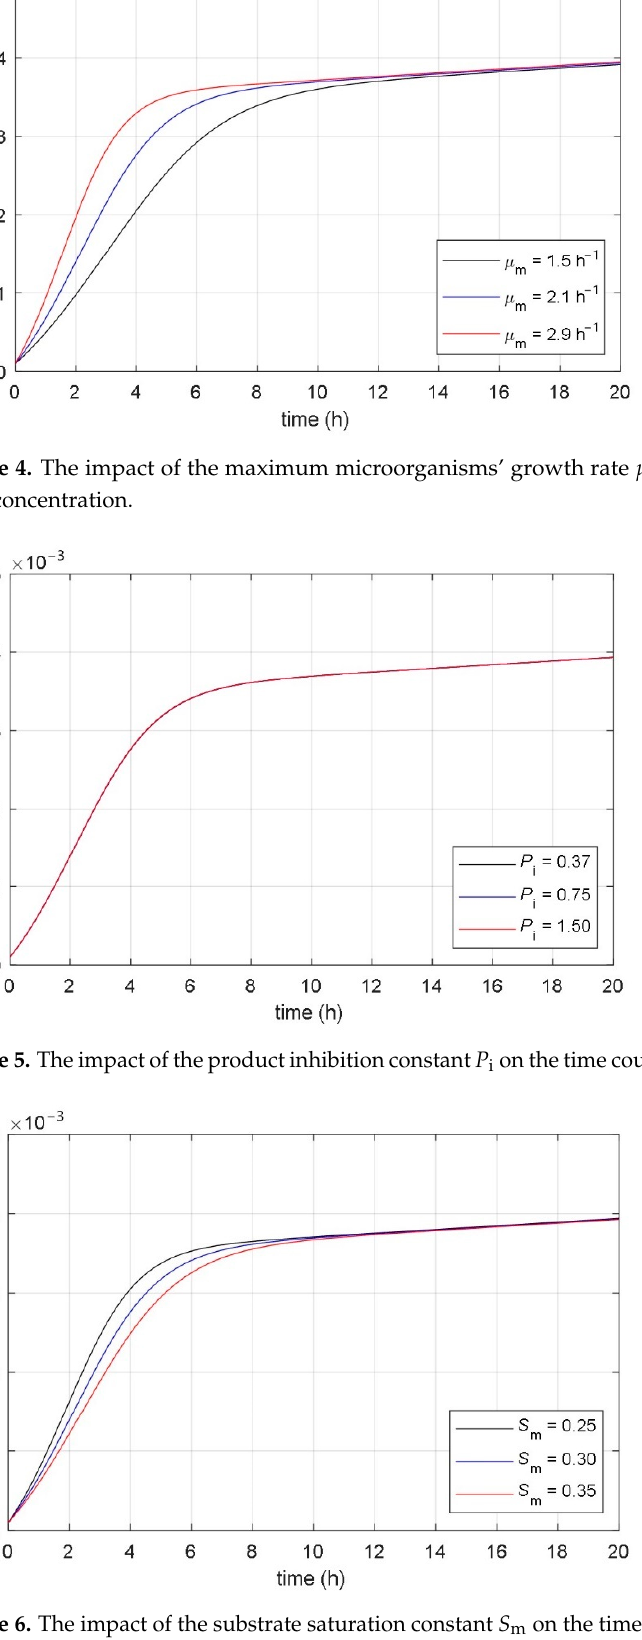
Figure 6. The impact of the substrate saturation constant S m on the time course of the CO 2 concentra-